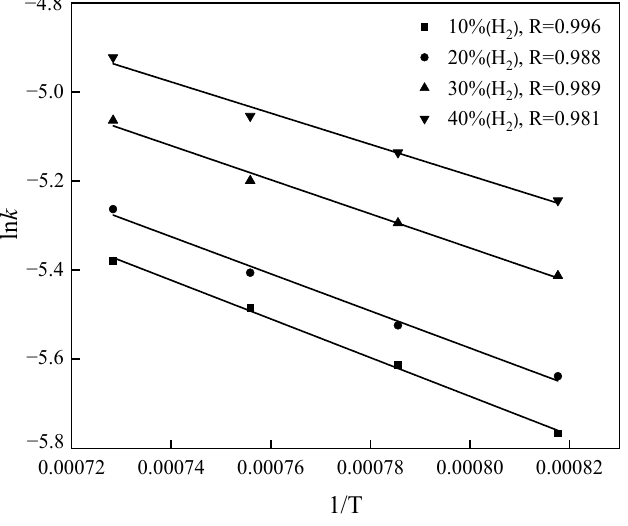
Minerals 2022 , 12 , x Figure 11. The relationship of [1 − (1 − f ) 1/3 ] with [1 – 3(1 − f ) 2/3 + 2(1 − f )].